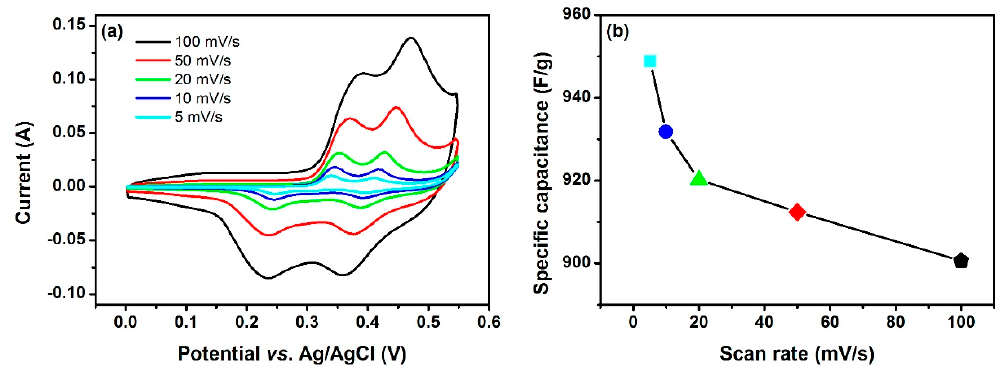
Figure 4. ( a ) Cyclic voltammogram (CV) curves and ( b ) specific capacitances of the Co 3 O 4 electrode at various scan rates.